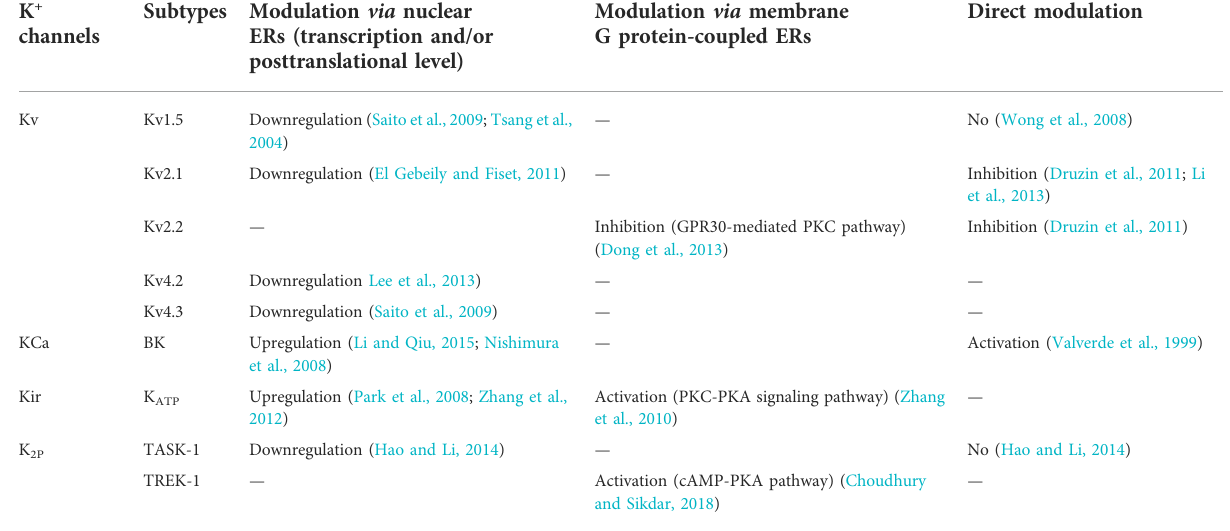
TABLE 1 Modulation of estrogens on K + channels for neuroprotection. K +